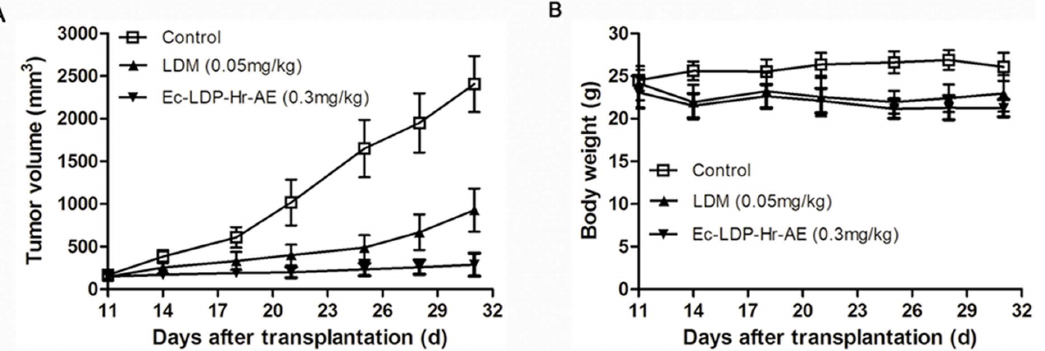
Figure 6. Invivo inhibitory effects of lidamycin (LDM) and Ec-LDP-Hr-AE. Nude mice (n=7) bearing human esophageal carcinoma KYSE150 xenografts were treated with LDM or Ec-LDP-Hr-AE on day 11 and day 21 after tumor inoculation by tail vein injection. The mean tumor volumes (A) and the mean body weights of mice (B) in each group are shown. Ec-LDP-Hr-AE at the dose of 0.3 mg/kg inhibited the growth of KYSE150 xenografts by 88%, which showed statistically significant differences compared with LDM treated group at the maximum tolerated dose (0.05 mg/kg) (P ,